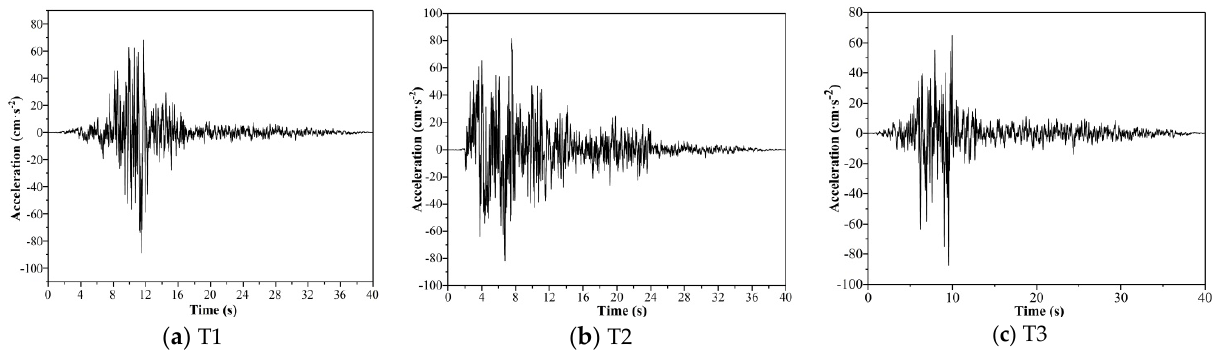
Figure 13. The time-history curves of the seismic waves. (1) Maximum base